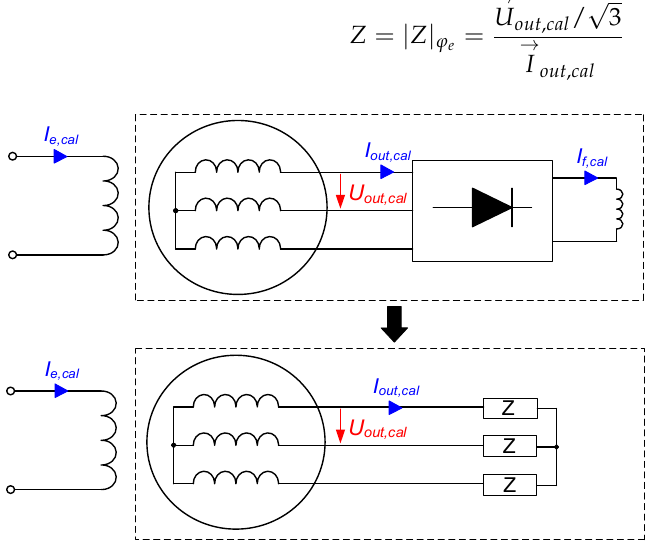
Figure 3. Exciter model (Upper figure: rectifier considered; Bottom figure: equivalent impedance Z simplification). Rotating elements are contained in rectangular sections.